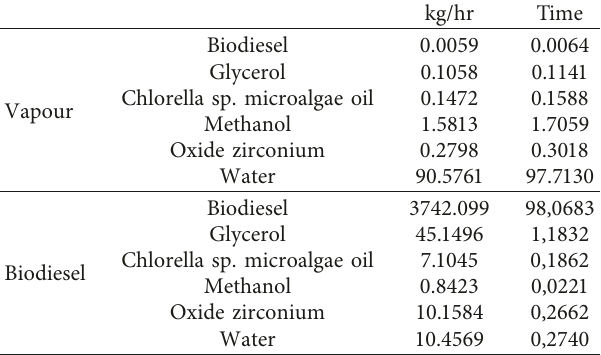
Table 4: Flash/V-101 distiller